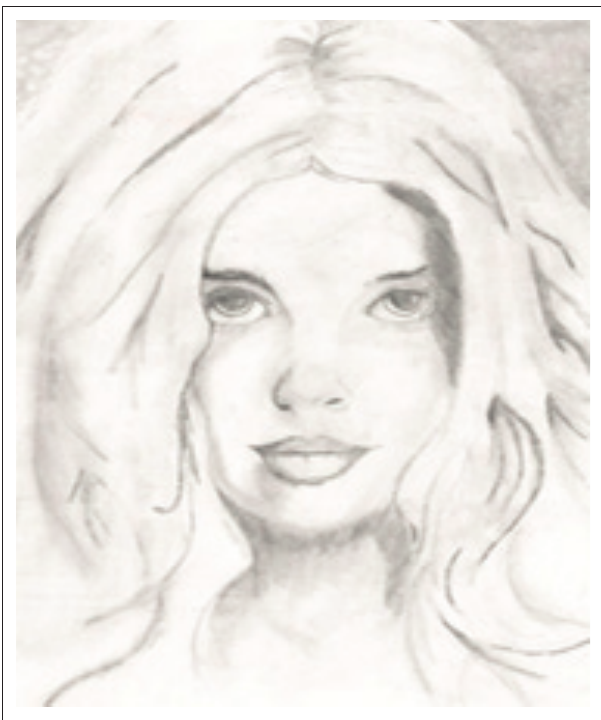
FIGURE 3: Portrait of a young student Nadine used for her digital story.